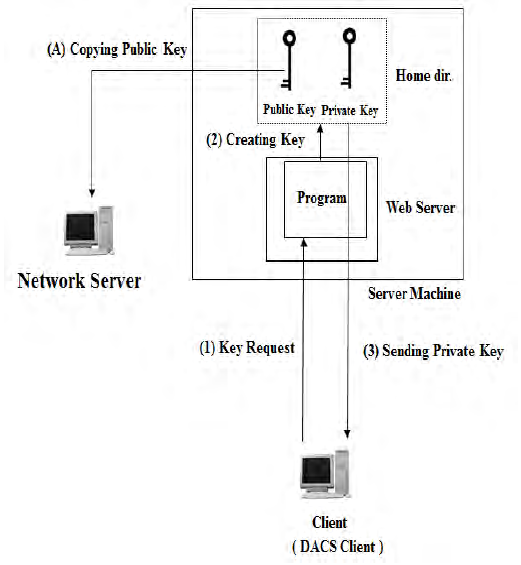
Figure 11 Mechanism of Key